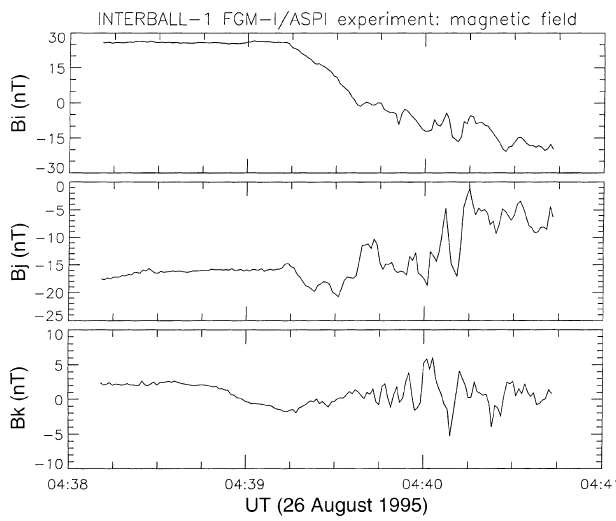
Fig. 6. High-latitude magnetopause crossing 26 August 1995. Mag- netic field components in the minimum variance frame of reference. B i : maximum variance direction; B j : intermediate variance direction; B k : minimum variance direction. See text